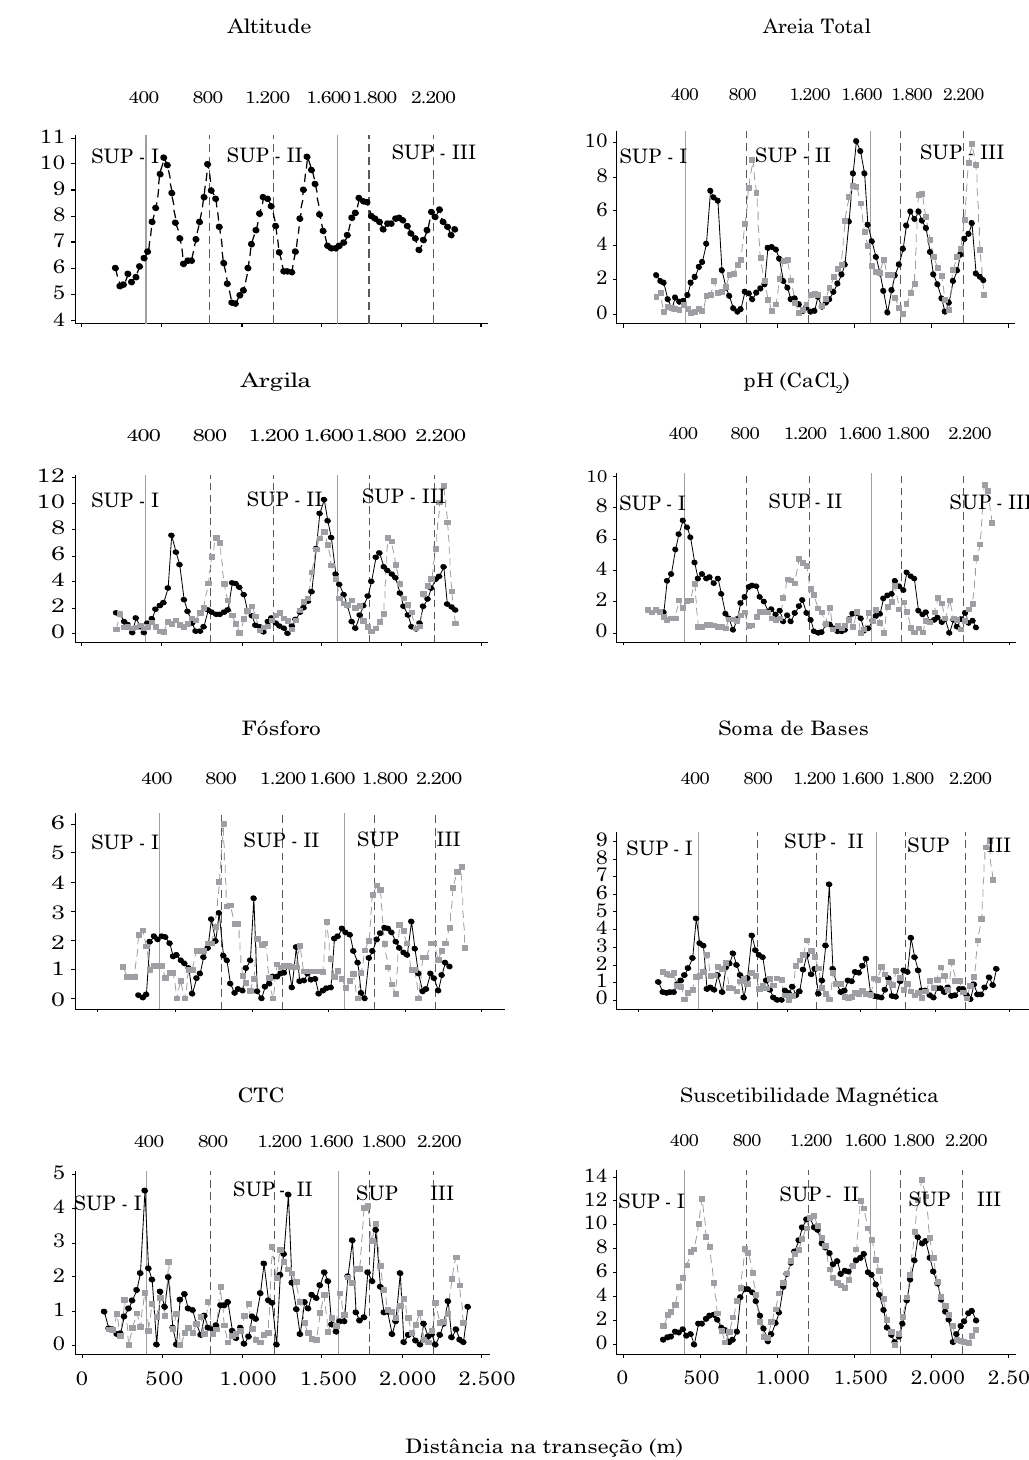
Figura 2. Valores da Split Moving Windows Dissimilarity Analysis (SMWDA), “Janelas Móveis”, dos atributos do solo, em uma transeção. Os “picos” mais elevados indicam locais de mudanças mais notáveis da inclinação do terreno ( nick points ). Os picos pretos, com linha contínua, e os cinzas, com linha pontilhada, representam as profundidades de 0,00-0,20 e 0,60-0,80 m, respectivamente, com exceção da altitude. A linha contínua cinza separa as superfícies geomórficas e, as tracejadas, os segmentos de